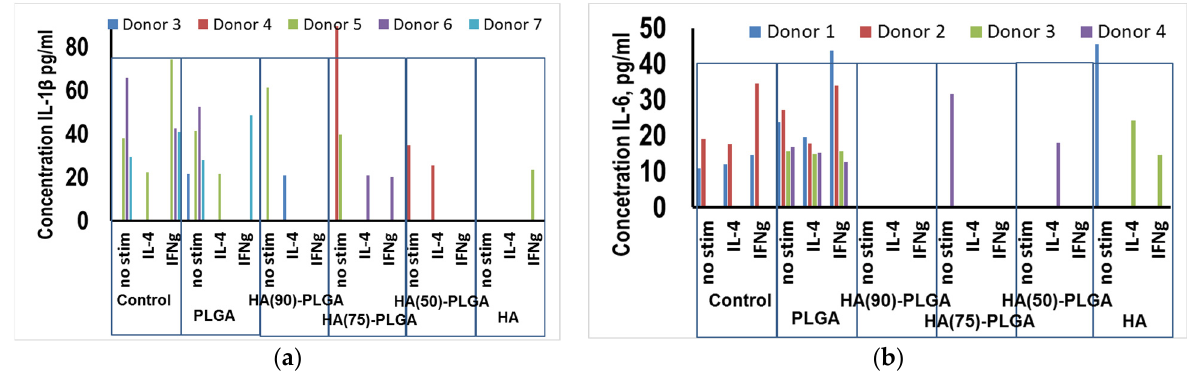
Figure 15. Influence of composite materials on the secretion of cytokines by primary human macrophages, depending on the direction of their differentiation ( a ) IL-1 β ; ( b ) IL-6.